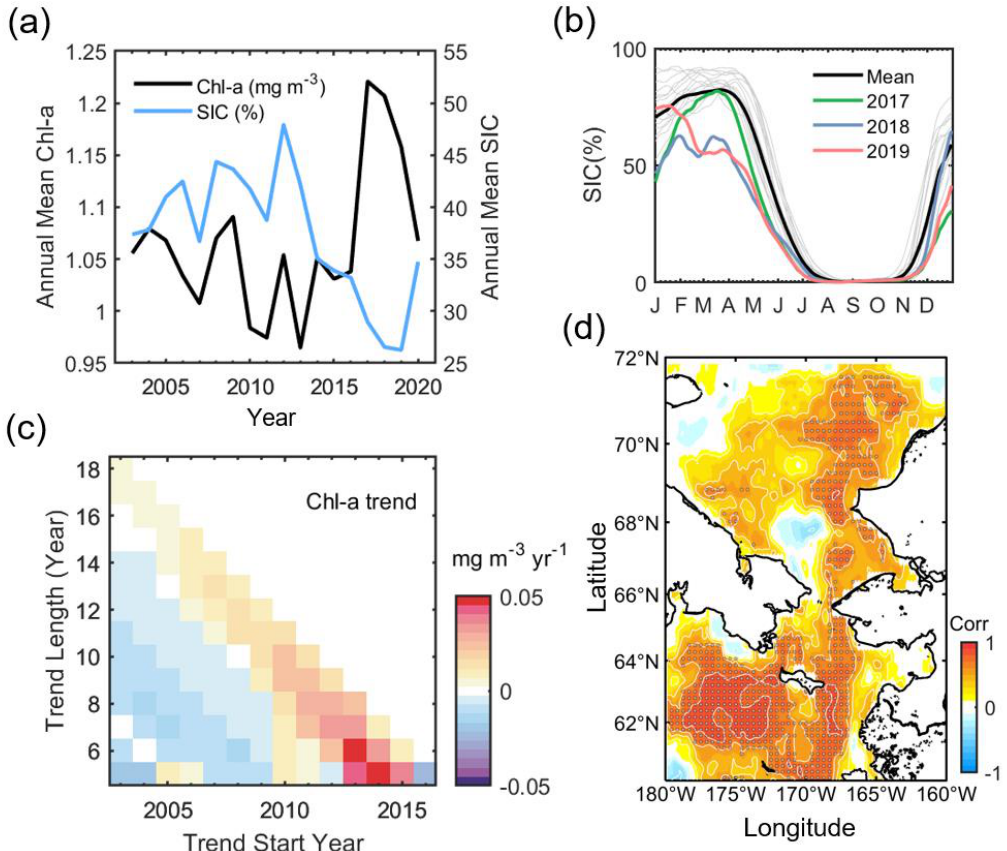
Figure 3. ( a ) Annual mean time-series of Chl-a (black) and SIC (blue). ( b ) Seasonal sea ice phenology (2003–2020). The thick black line denotes the mean of ice phenology in each year (thin gray lines). ( c ) The time-varying annual mean Chl-a trend. The Theil–Sen estimator estimated the trends. ( d ) Pearson’s correlation map between spatially averaged annual Chl-a (Figure 3a) and yearly Chl-a at each pixel. The shaded area indicates the region where the statistical significance exceeds 95% of the confidence level according to the Student’s